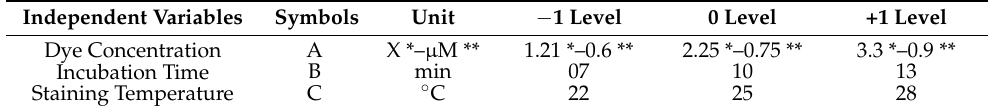
Table 1. Codedandactuallevelsoftheindependentvariablesforthecentralcompositedesignexperiments. Independent